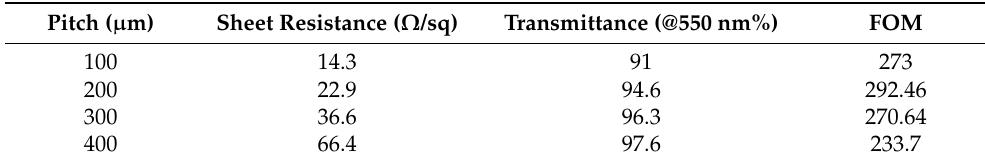
Figure 2. Ag grid electrode images with di ff erent pitches ( a ) 100 µm; ( b ) 200 µm; ( c ) 300 µm; ( d ) 400 µm. Table 1. Parameters for the photovoltaic properties of the Ag grid electrodes.